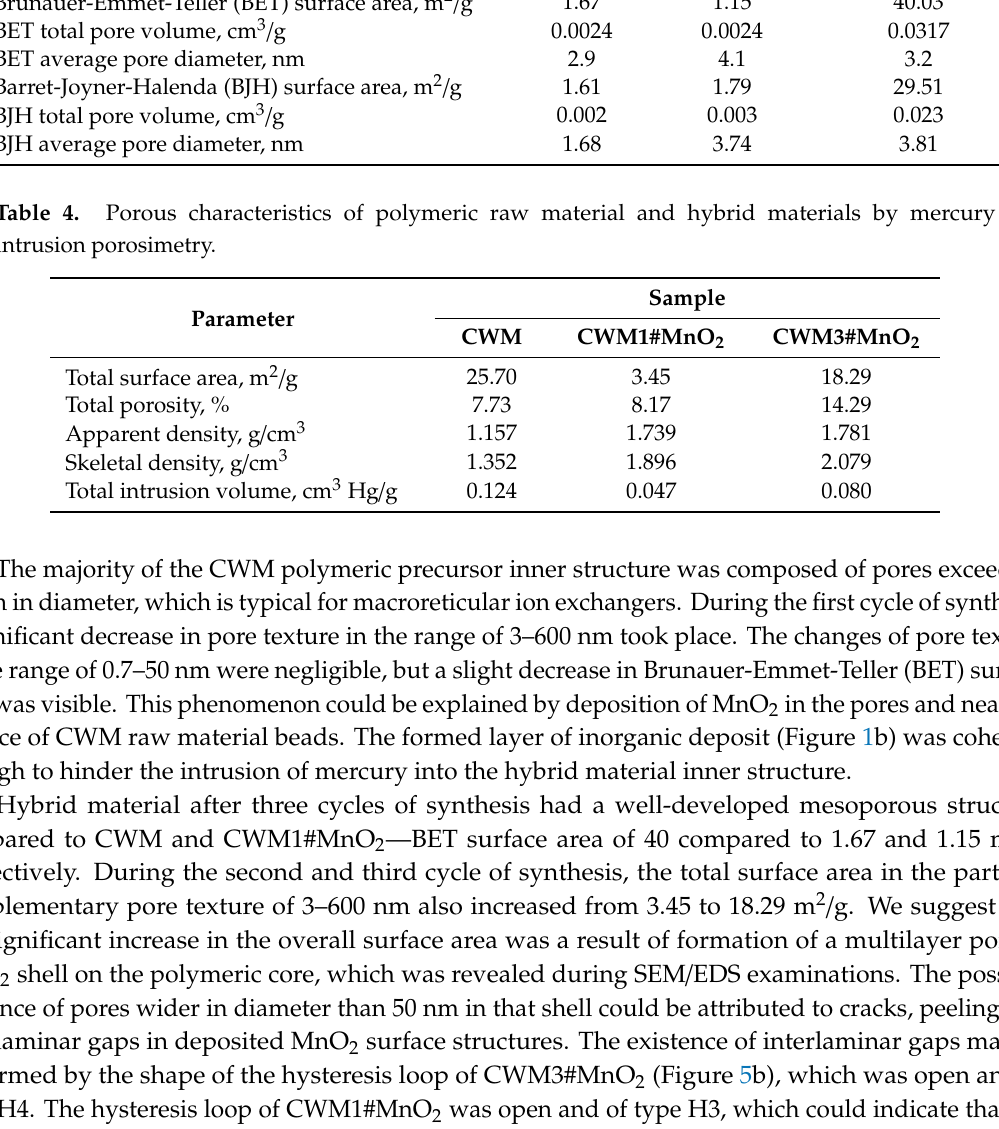
Table 3. Porous characteristics of polymeric raw material and hybrid materials by N 2 adsorption at 77 K. Parameter